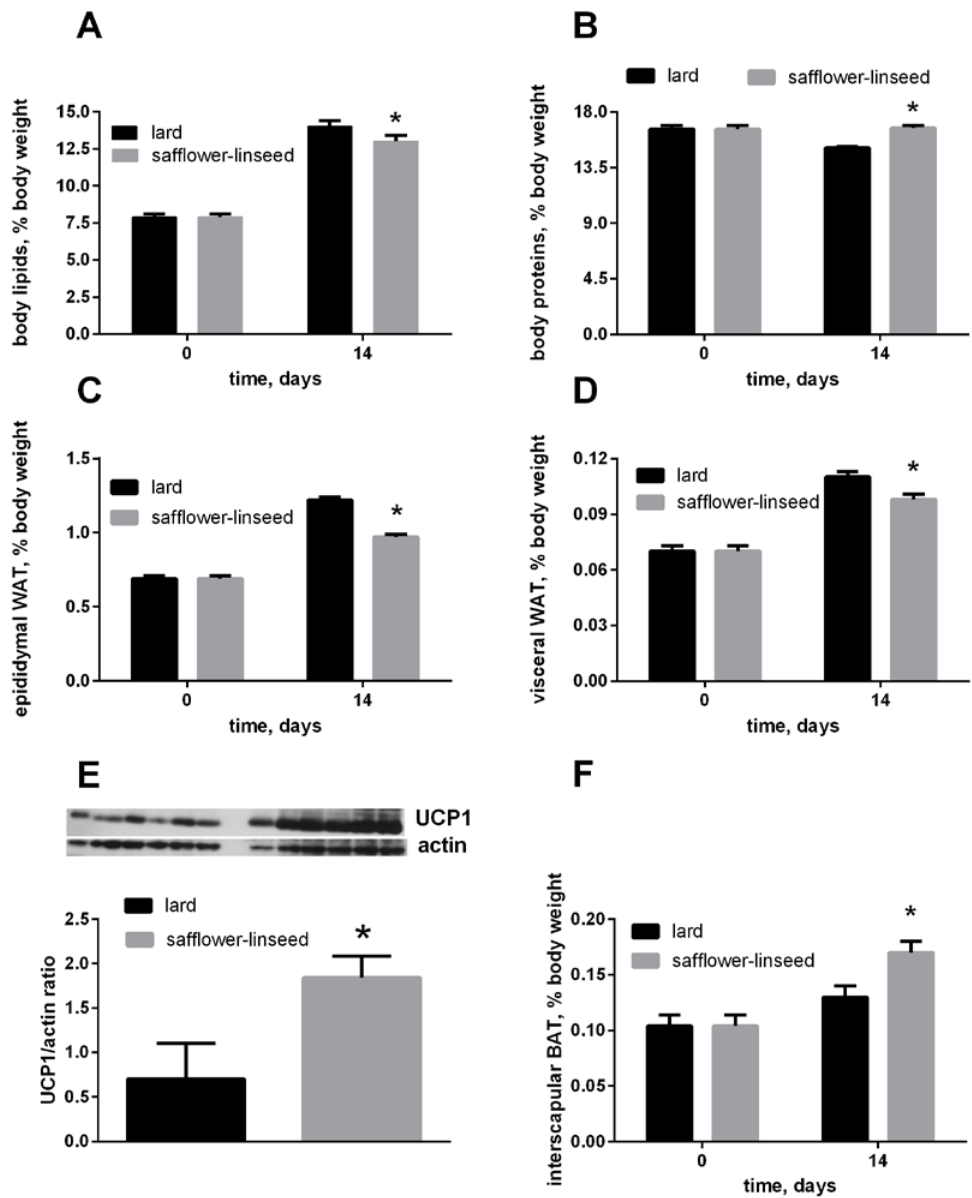
Figure 1. Body lipids ( A ) body proteins; ( B ) body epididymal WAT; ( C ) body visceral WAT ( D ) and body interscapular BAT ( F ) at day 0 and 14 of the experiment and UCP1 content in interscapular BAT ( E ) at day 14 of experiment in rats fed lard or safflower-linseed high fat diet. Values are reported as means with their standard errors. n = 8 different rats, except that for UCP1 western blots ( n = 6). * p < 0.05 compared to lard. WAT = white adipose tissue, BAT = brown adipose tissue, UCP1 = uncoupling protein 1. Table 2. Energy balance in rats fed lard or safflower-linseed high fat diet.